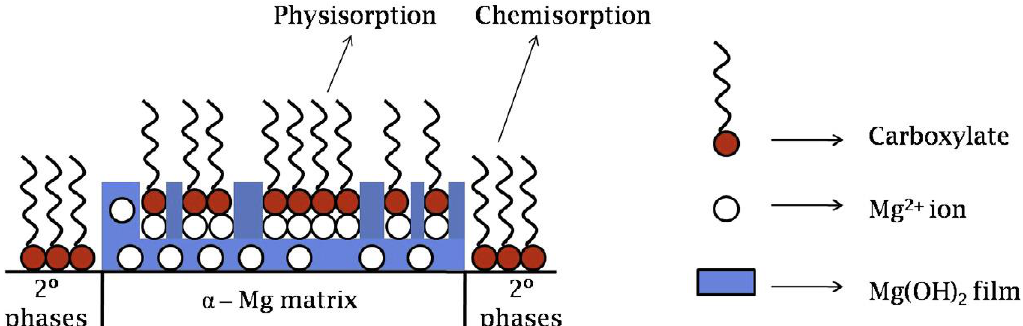
Figure 10. The schematic representation for the surface adsorption of alkyl carboxylates over different phases of ZE41. Adapted from [112] with permission from Elsevier.